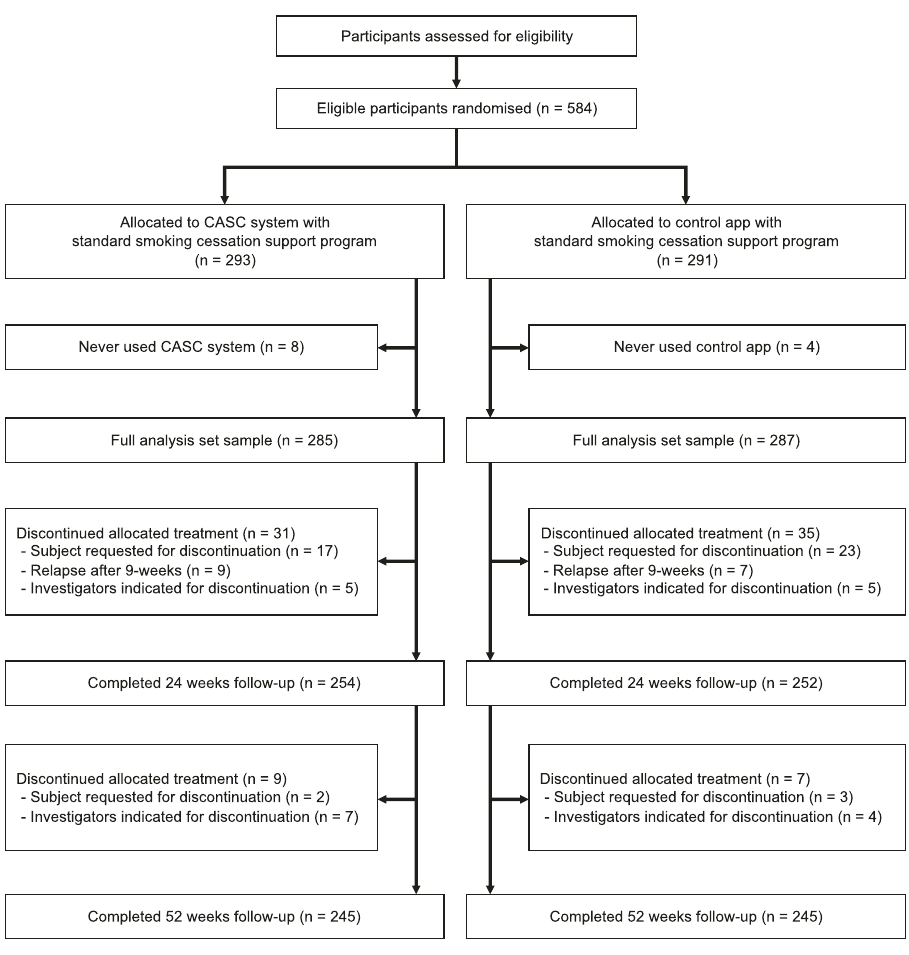
Fig. 2 CONSORT fl ow